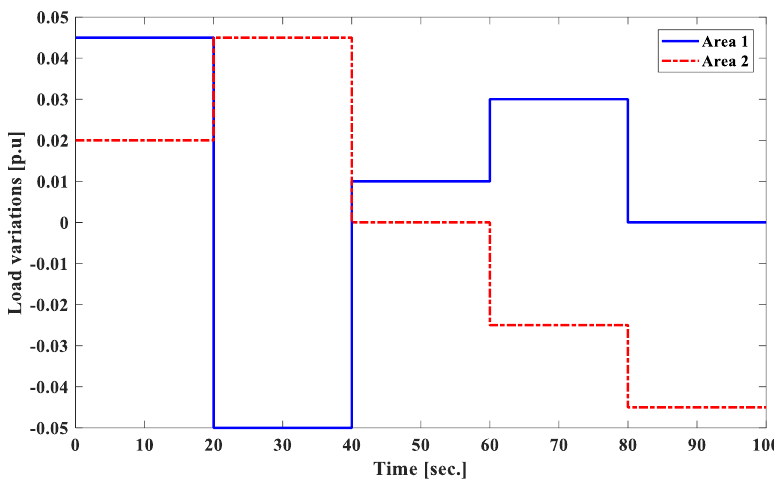
Figure 15. Variation load [p.u.] of areas 1 and 2 of the power system.